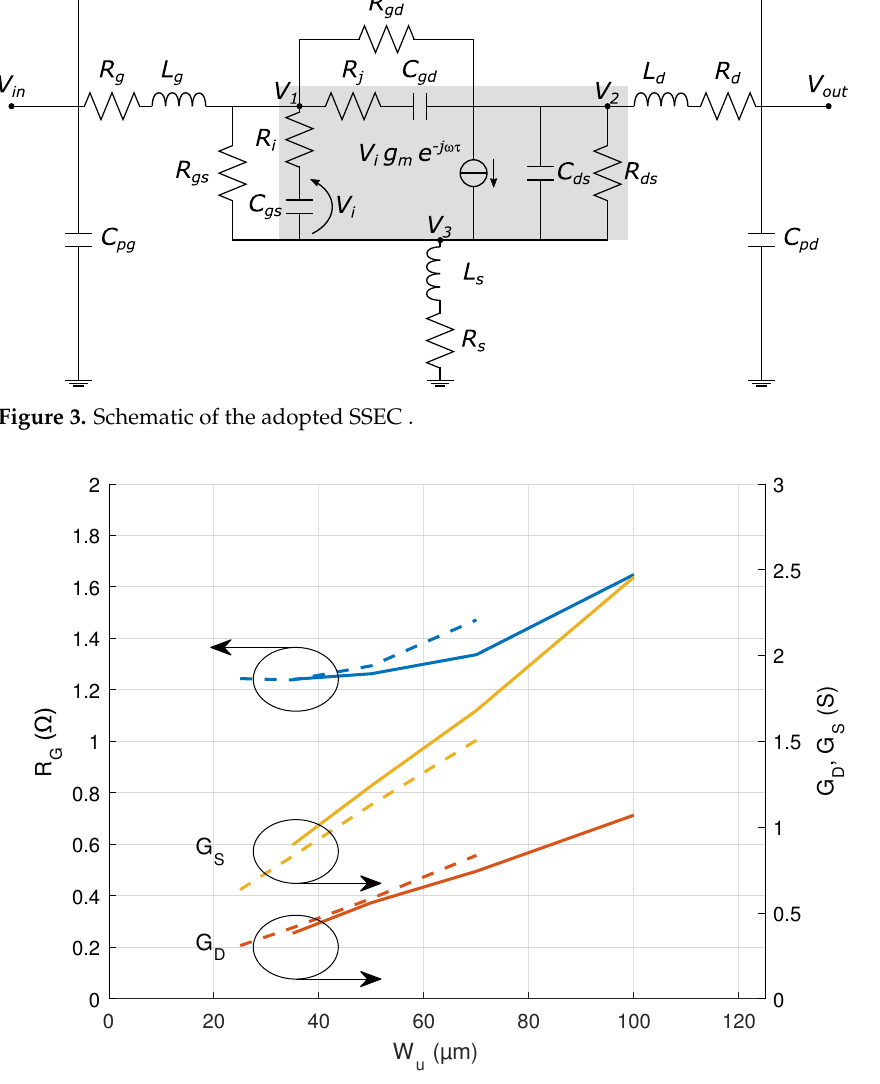
Figure 4. Extracted resistive elements of the extrinsic circuit. Continuous lines: D01GH. Dashed lines: